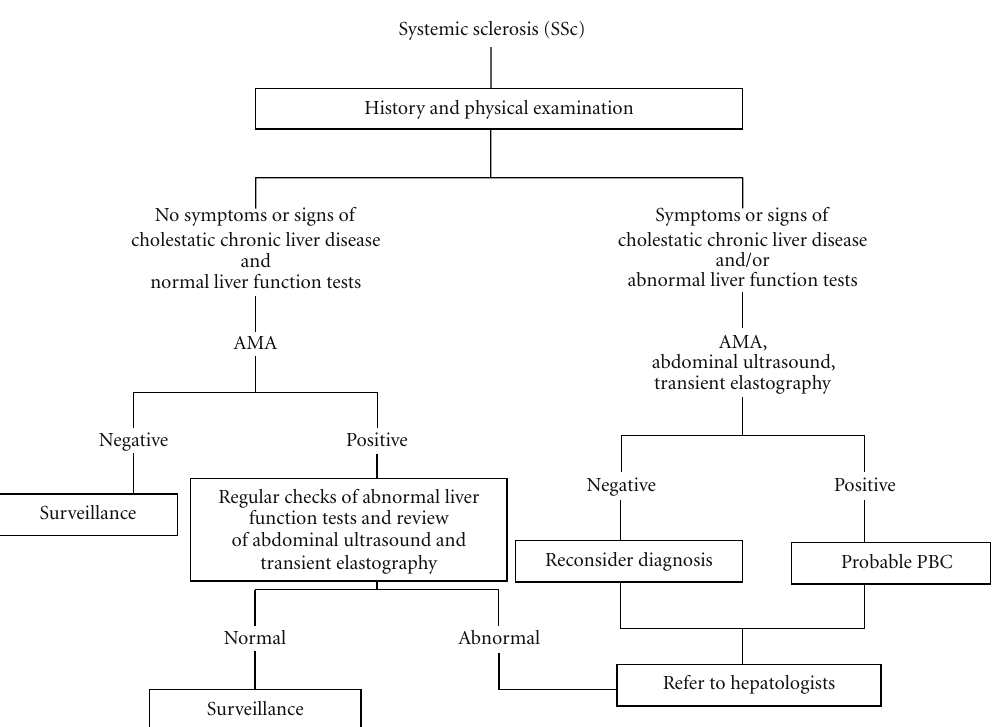
Figure 1: A proposed algorithm for the screening and diagnosis of primary biliary cirrhosis (PBC) in patients with established systemic sclerosis